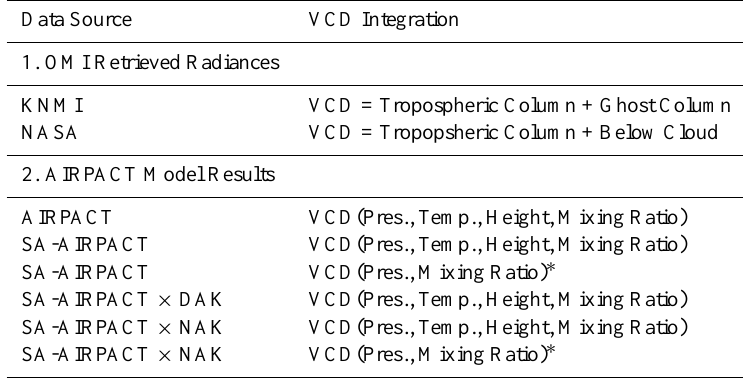
Table 1. The tropospheric NO 2 columns analyzed and the variables used for VCD.